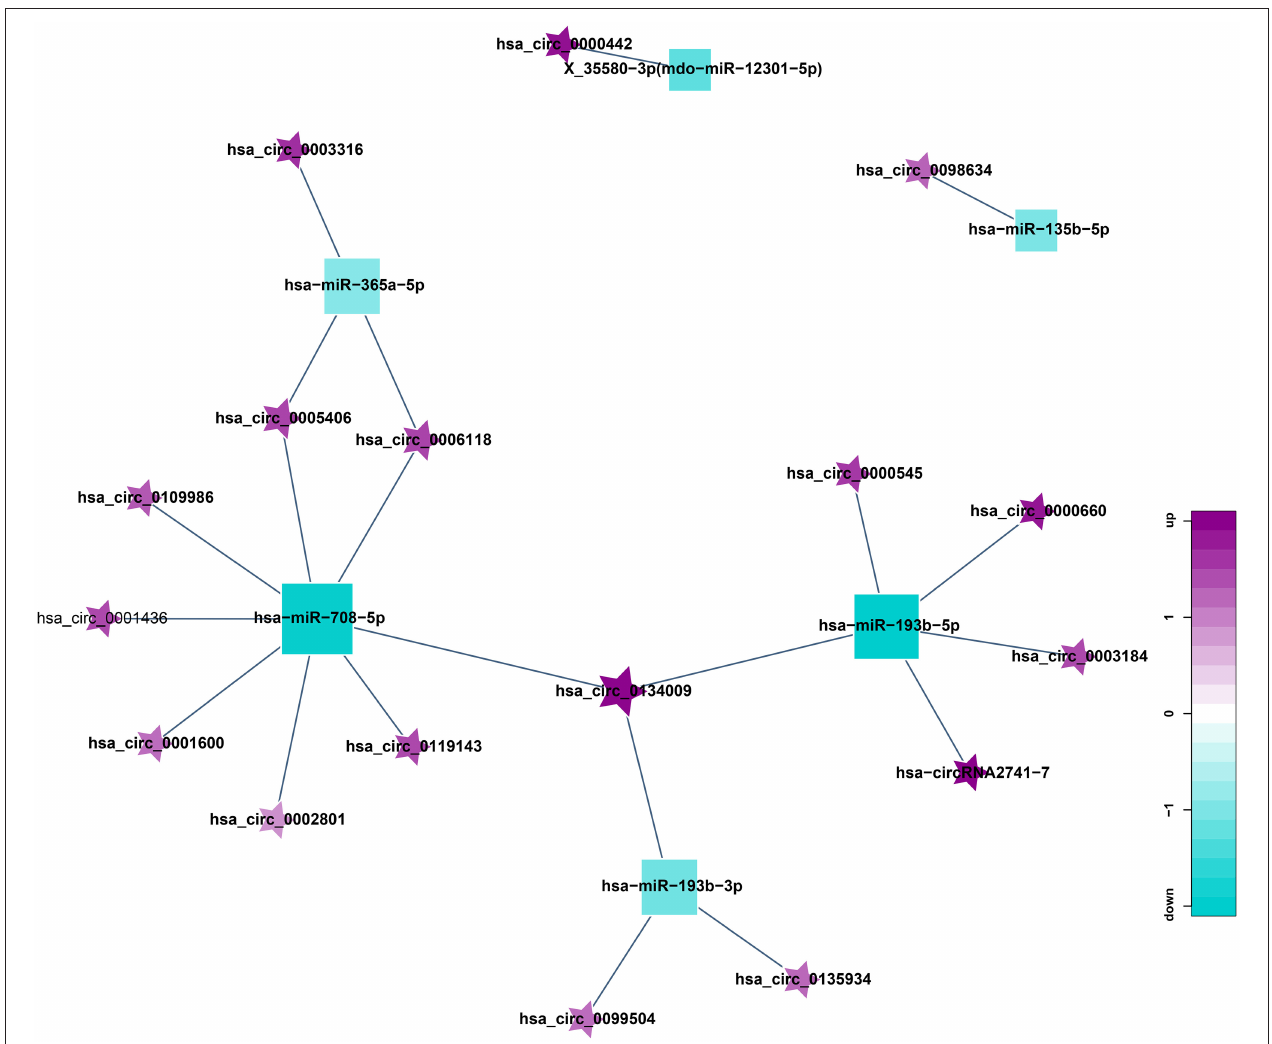
FIGURE 8 | Correlation analysis diagram of circRNA-miRNA (Square: miRNA; Pentagram: circRNA; Blue: down-regulation; Purple: